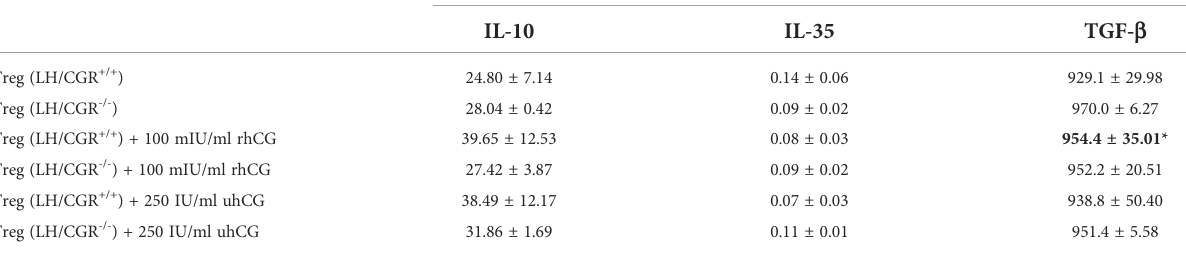
TABLE 1 Effects of recombinant hCG (rhCG) and urine-derived hCG (uhCG) on cytokine secretion by wild-type (LH/CGR +/+ ) and LH/CGR- de fi cient (LH/CGR -/- ) Treg cells. Cell type and